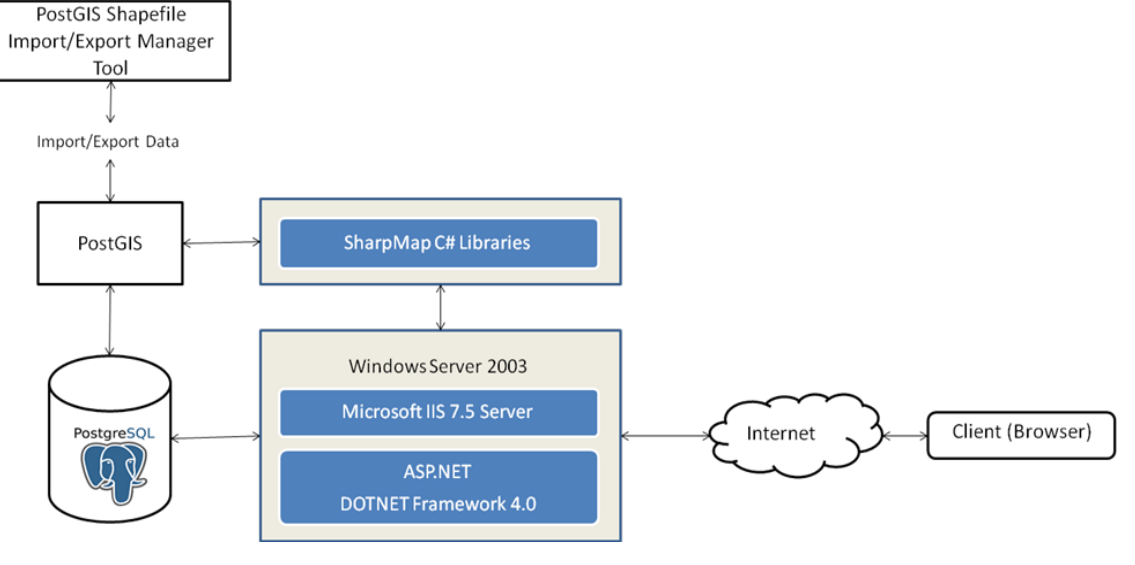
Figure 4 : Architecture of SharpMap